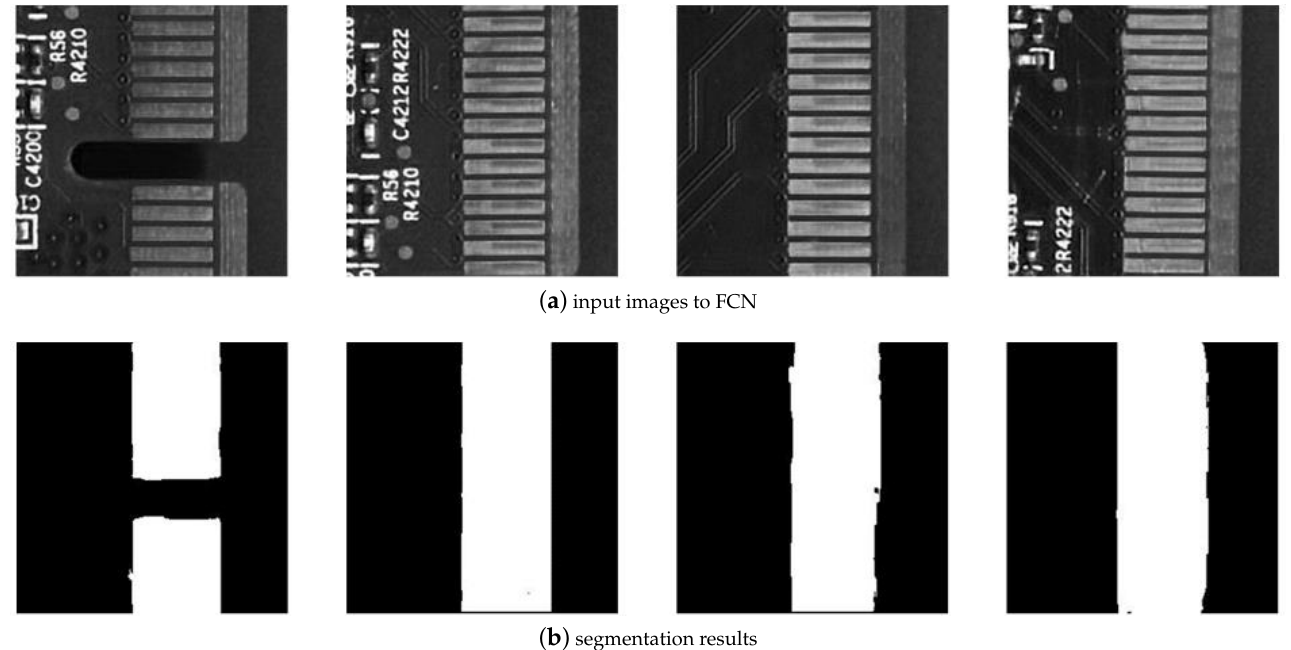
Figure 10. Examples of segmentation results produced by FCN for the images of gold finger connectors. ( a ) The input images to the FCN; ( b ) the segmentation results, where the white areas are the gold finger area, and the black areas are the area outside gold finger